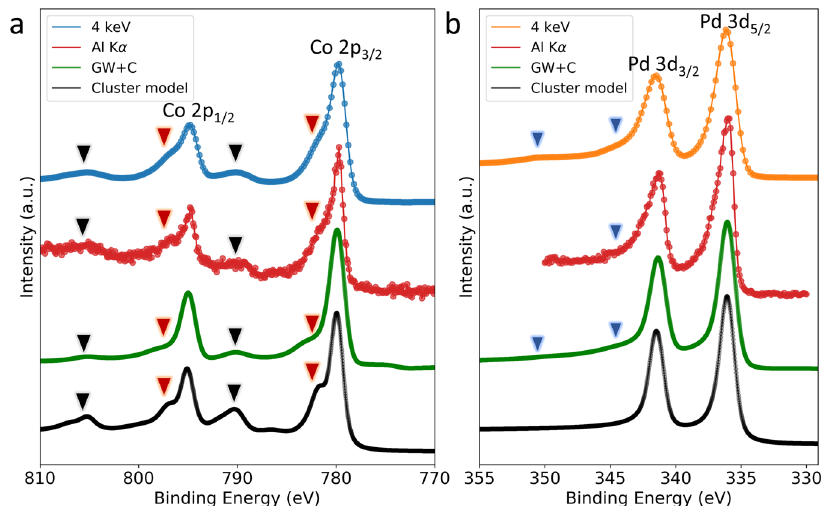
Fig. 2 Core-level photoemission spectra of PdCoO 2 . a Co 2 p spectra collected by using both tender/hard X-rays ( h ν = 4 keV) and monochromated Al K α X-rays ( h ν = 1.486 keV) are compared to cluster model (black) and GW + cumulant (green) results. The black triangles indicate charge-transfer satellites while the red triangles indicate the position of the feature resulting from nonlocal screening. b Equivalent graphs for the Pd 3 d spectrum. The blue triangles indicate plasmon satellites. Note that the cluster model calculation does not reproduce the plasmon satellites while the GW + cumulant approach